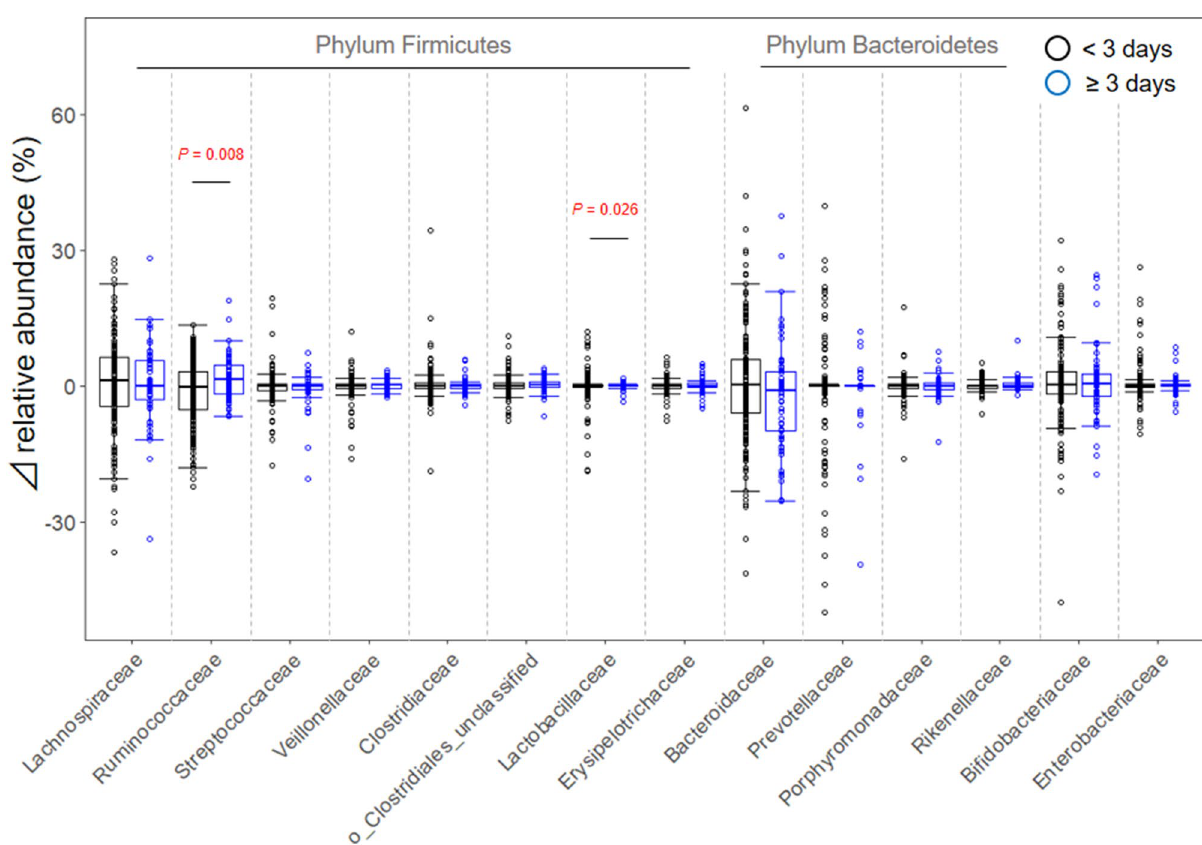
Figure 5. Changes in the relative abundance of each predominant bacteria during a year in subjects consuming fermented milk products containing Lacticaseibacillus paracasei strain Shirota (LcS) < 3 or ≥ 3 days/week over the past 10-year period. Independent differences between groups in terms of dispersions of changes in the abundance were assessed by Levene’s tests. P values with < 0.05 are